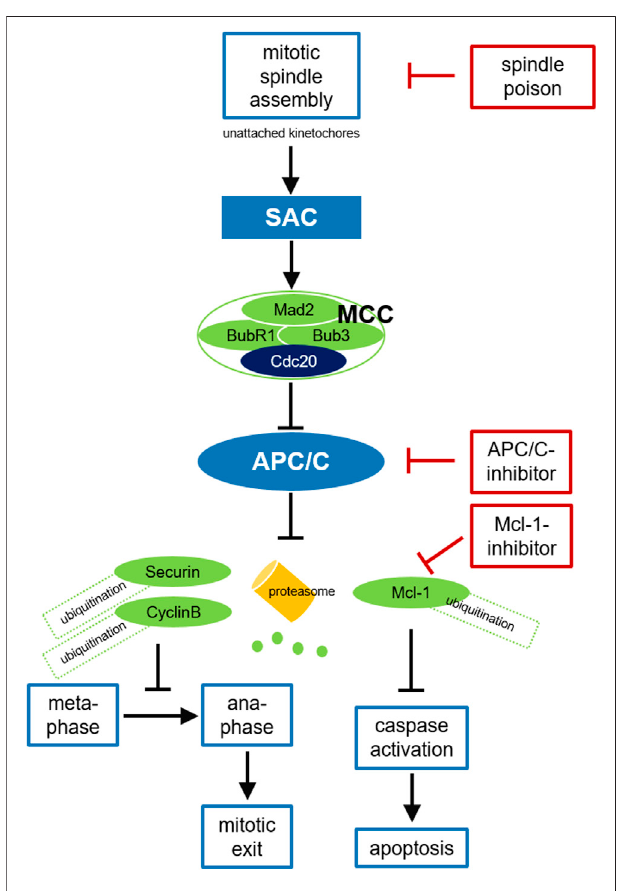
FIGURE 2 | Cancer treatment targeting the APC/C. Due to disturbed microtubule kinetics after spindle poison treatment with resulting defective chromosome attachment and free kinetochores, the SAC cannot be satis fi ed and the MCC is formed. After binding to Mad2, BubR1, and Bub3 in the MCC Cdc20 can no longer activate the APC/C. APC/C inhibition leads to stabilization of securin and cyclin B, preventing chromosome segregation and mitotic exit. Prolonged mitotic arrest triggers Mcl-1-degradation, thus caspase activation and apoptosis in mitosis. SAC-de fi cient malignant cells maysurvivetreatmentwithspindlepoisonsduetoresidualAPC/Cactivityand slow cyclinB-degradation.Inhibition ofAPC/Cortheproteasomecanprevent this mitotic slippage, consolidate the mitotic block and enhance the antitumor effect. Mcl-1 inhibition may additionally promote apoptosis. SAC, spindle assembly checkpoint; MCC, mitotic checkpoint complex; APC/C, anaphase promoting